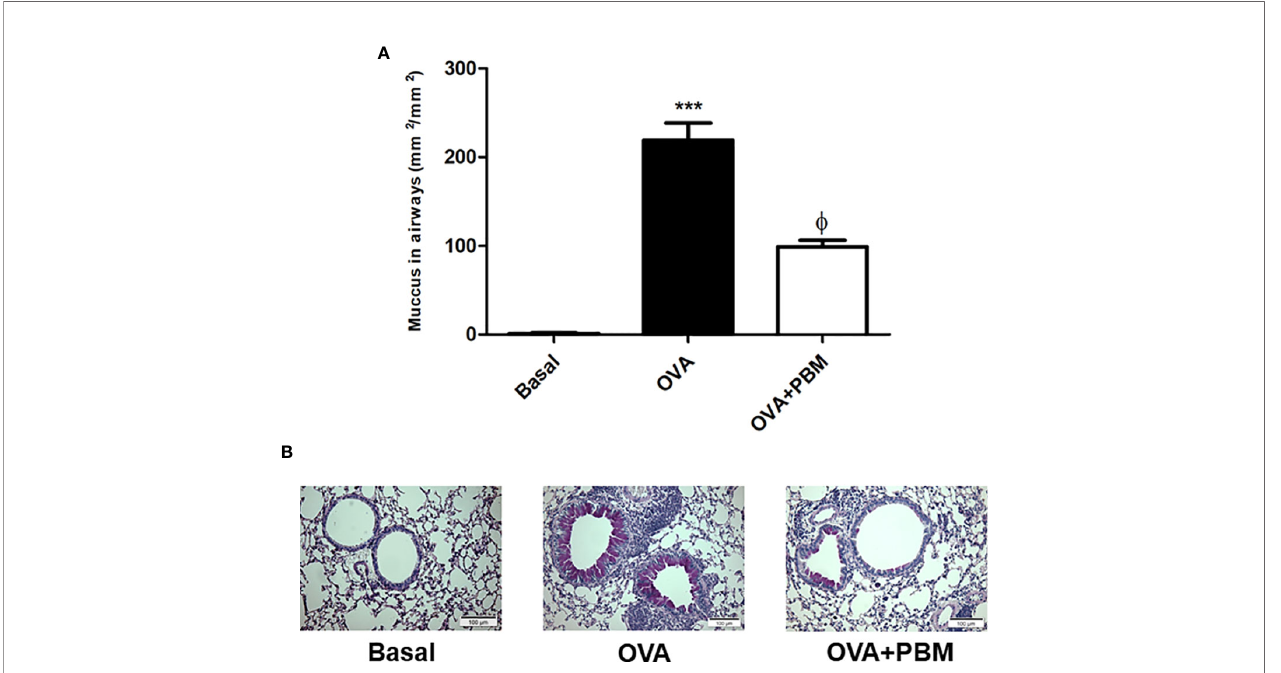
FIGURE 4 | Effect of photobiomodulation on airway mucus production. Neutral mucin-producing goblet cells were stained with PAS or mucus density was evaluated in the bronchial region between epithelial basement membrane and luminal cell membrane (lumen). Quanti fi cation of mucus production in the airways (A) .The photomicrographs represent all the groups studied (B) . Basal group, n = 5; OVA group, n = 7; PBM group, n = 5; OVA+ PBM, n = 8. Two independent sets of experiments were carried out. Data represent mean ± standard error (SEM). ***p < 0.001 in relation to the Basal group. fp < 0.001 in relation to the OVA group. f p < 0.001 in relation to the OVA group.